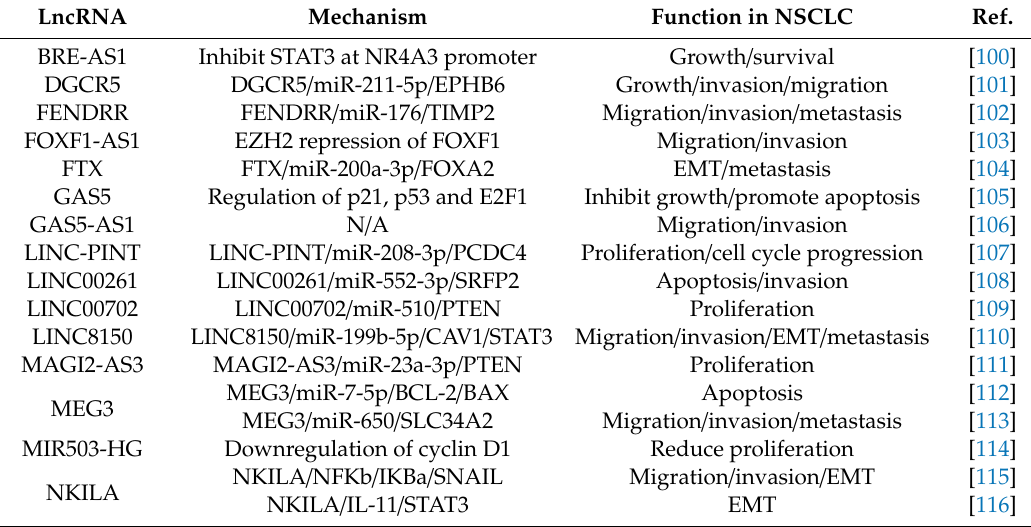
Table 2. Tumor suppressor lncRNAs downregulated in